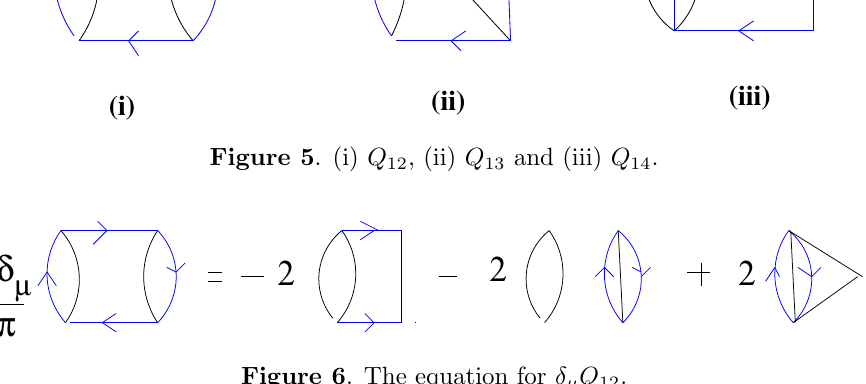
Figure 6 . The equation for (cid:14) (cid:22) Q 12 .